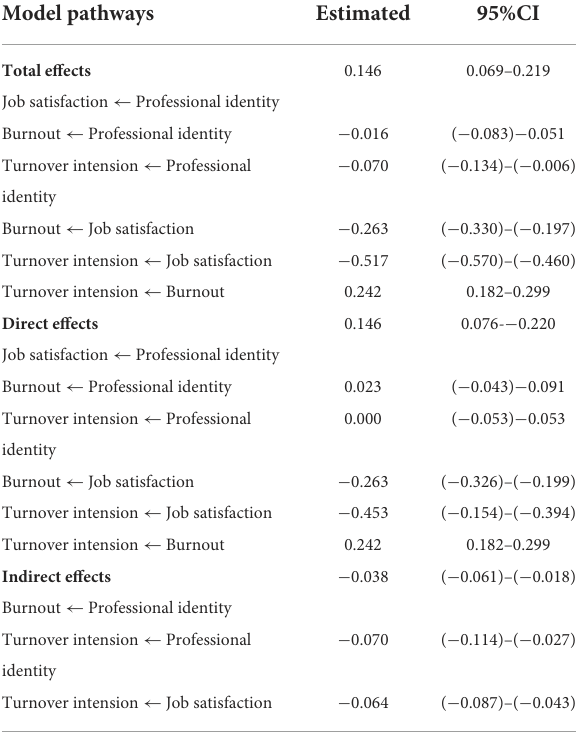
TABLE 6 Significance test of the mediating test.